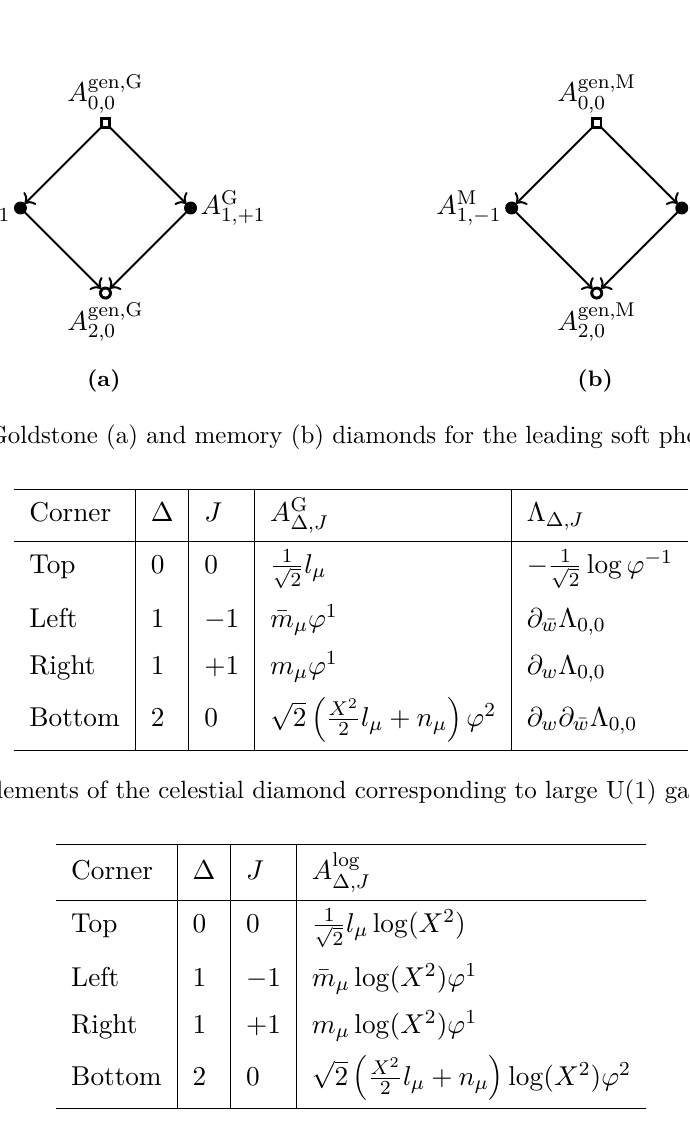
Table 13. Elements of the celestial diamond corresponding to electromagnetic